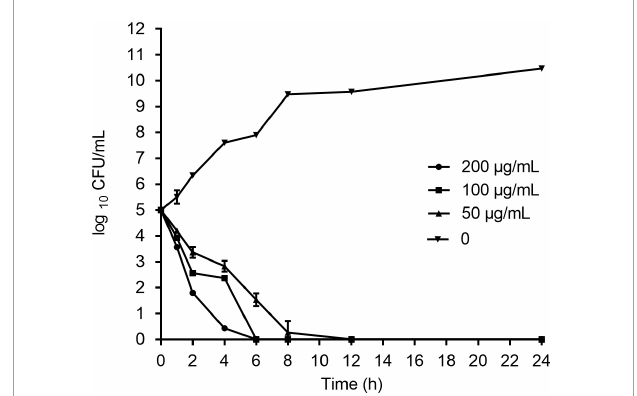
FIGURE2 Time-dependent killing curves of Salmonella Pullorum incubated with HJH-3. Co-incubation Salmonella Pullorum with the different concentrations of HJH-3 (0, 50, 100, and 200 µ g/ml) in MH broth medium for 24 h. Aliquots were collected at 0, 1, 2, 4, 6, 8, and 24 h to count the bacteria. Error bars represent means ± SD. The experiments were repeated three